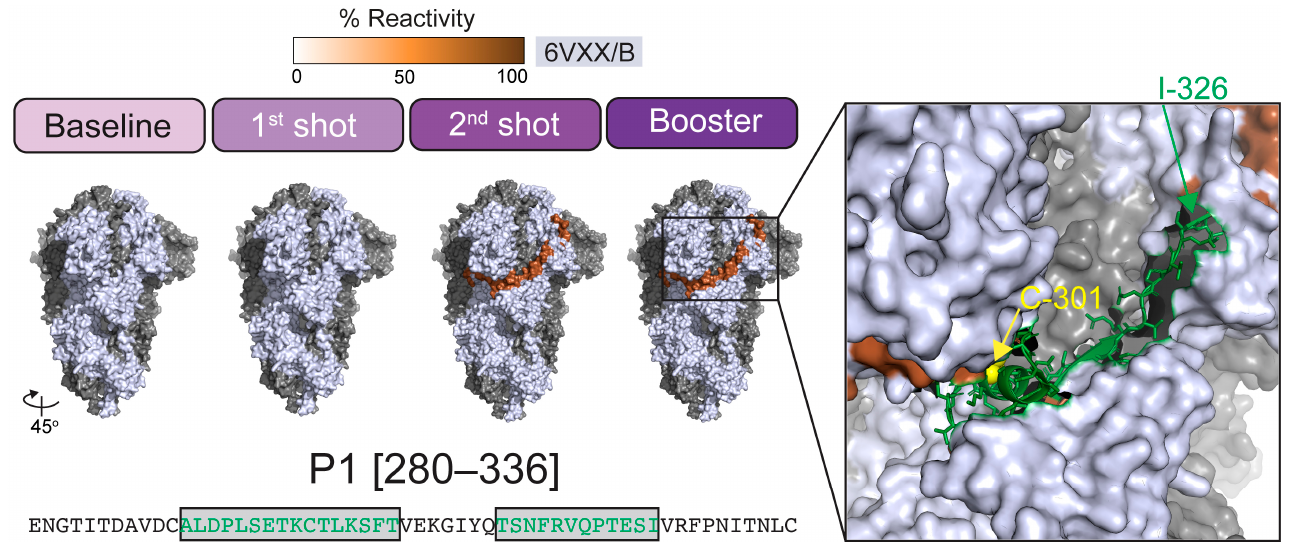
Figure 4. Novel boosted epitope projected on the 3D structure of SARS-CoV-2 spike (S) glycoprotein. The closed-state trimeric structure of the SARS-CoV-2 S glycoprotein was pulled from the Protein Data Bank (PDB ID: 6VXX). For brevity, only the B monomer is highlighted (light blue), and the vaccine-boosted P1 sequence was mapped onto the structure and colored based on % subject reactivity. The region with high surface accessibilities was highlighted in green and indicated on the primary sequence (boxed) and the tertiary structure.